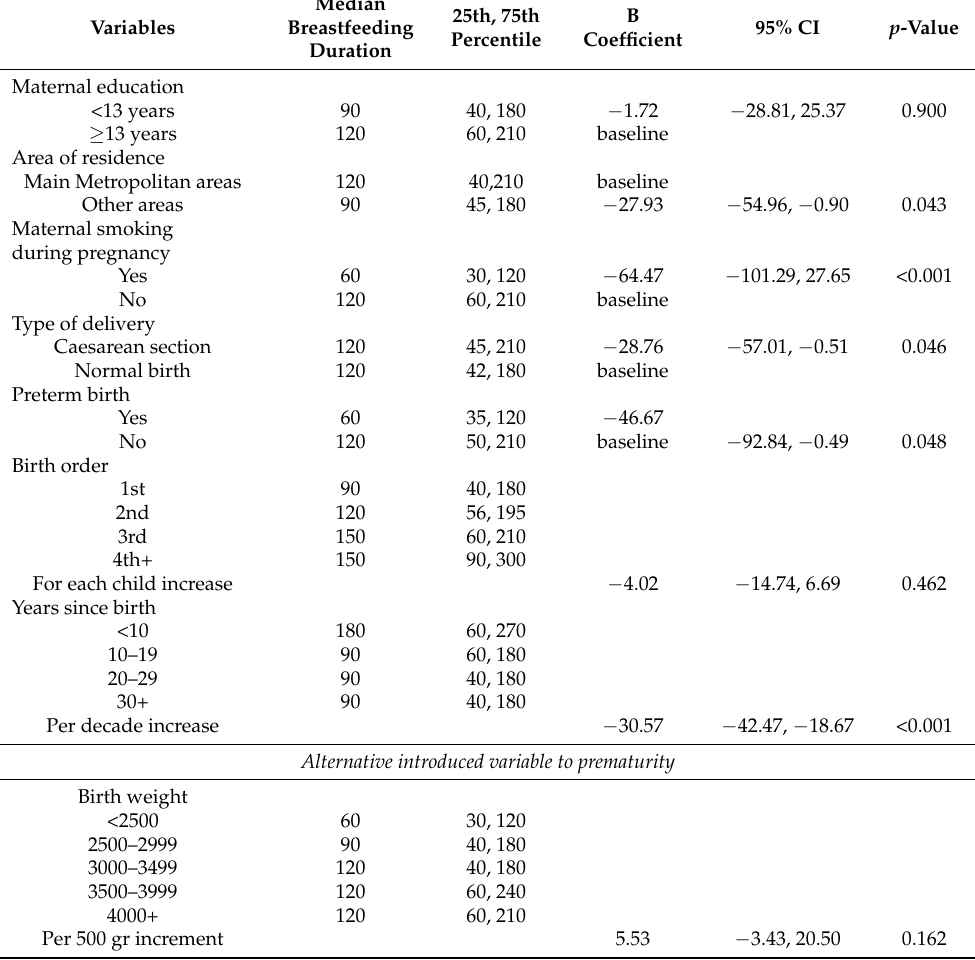
Table 3. Multilevel mixed-model regression-analysis-derived coefficients ( b ) and 95% Confidence Intervals (95% CI) assessing the association of maternal sociodemographic and lifestyle characteristics and perinatal factors with breastfeeding